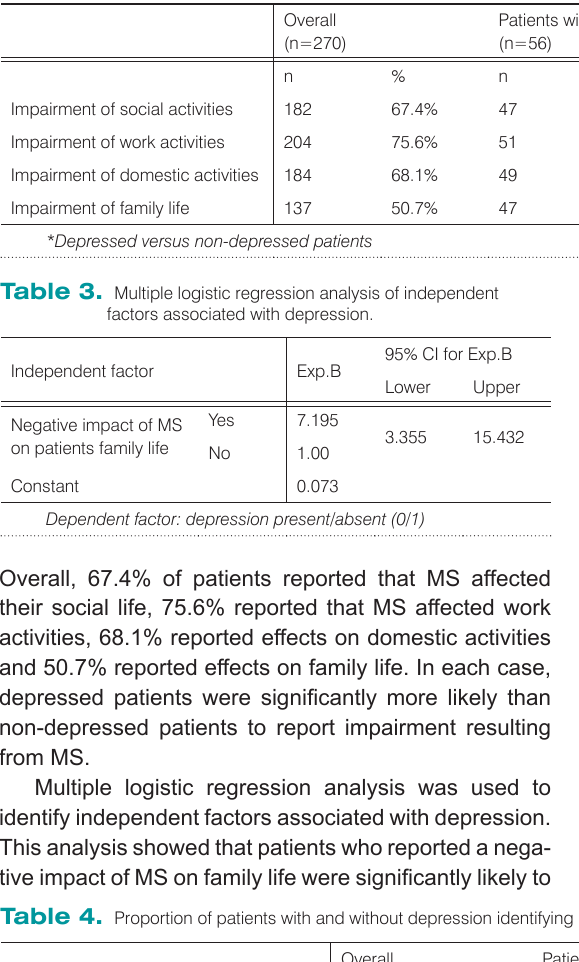
Table 2. Proportion of patients reporting impairment by MS of social, work and domestic activities.